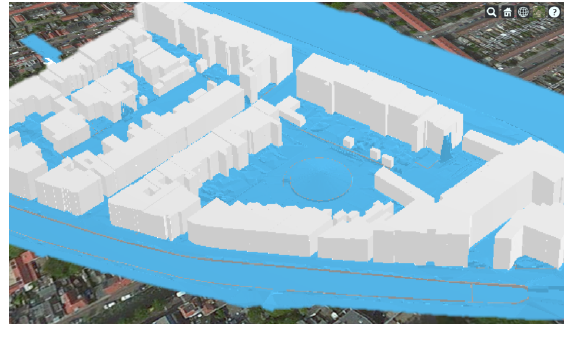
Figure 3: Cesium visualization of